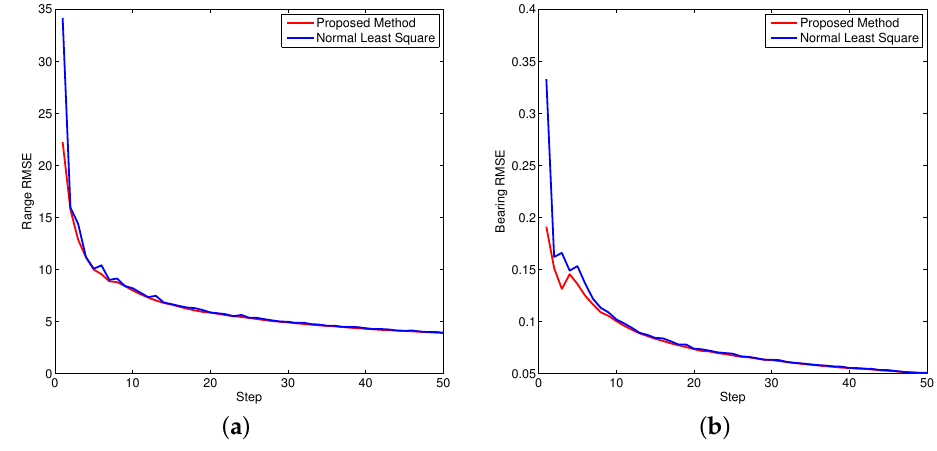
Figure 9. Bias RMSE for object two. ( a ) Bias RMSE in range; ( b ) Bias RMSE in bearing.